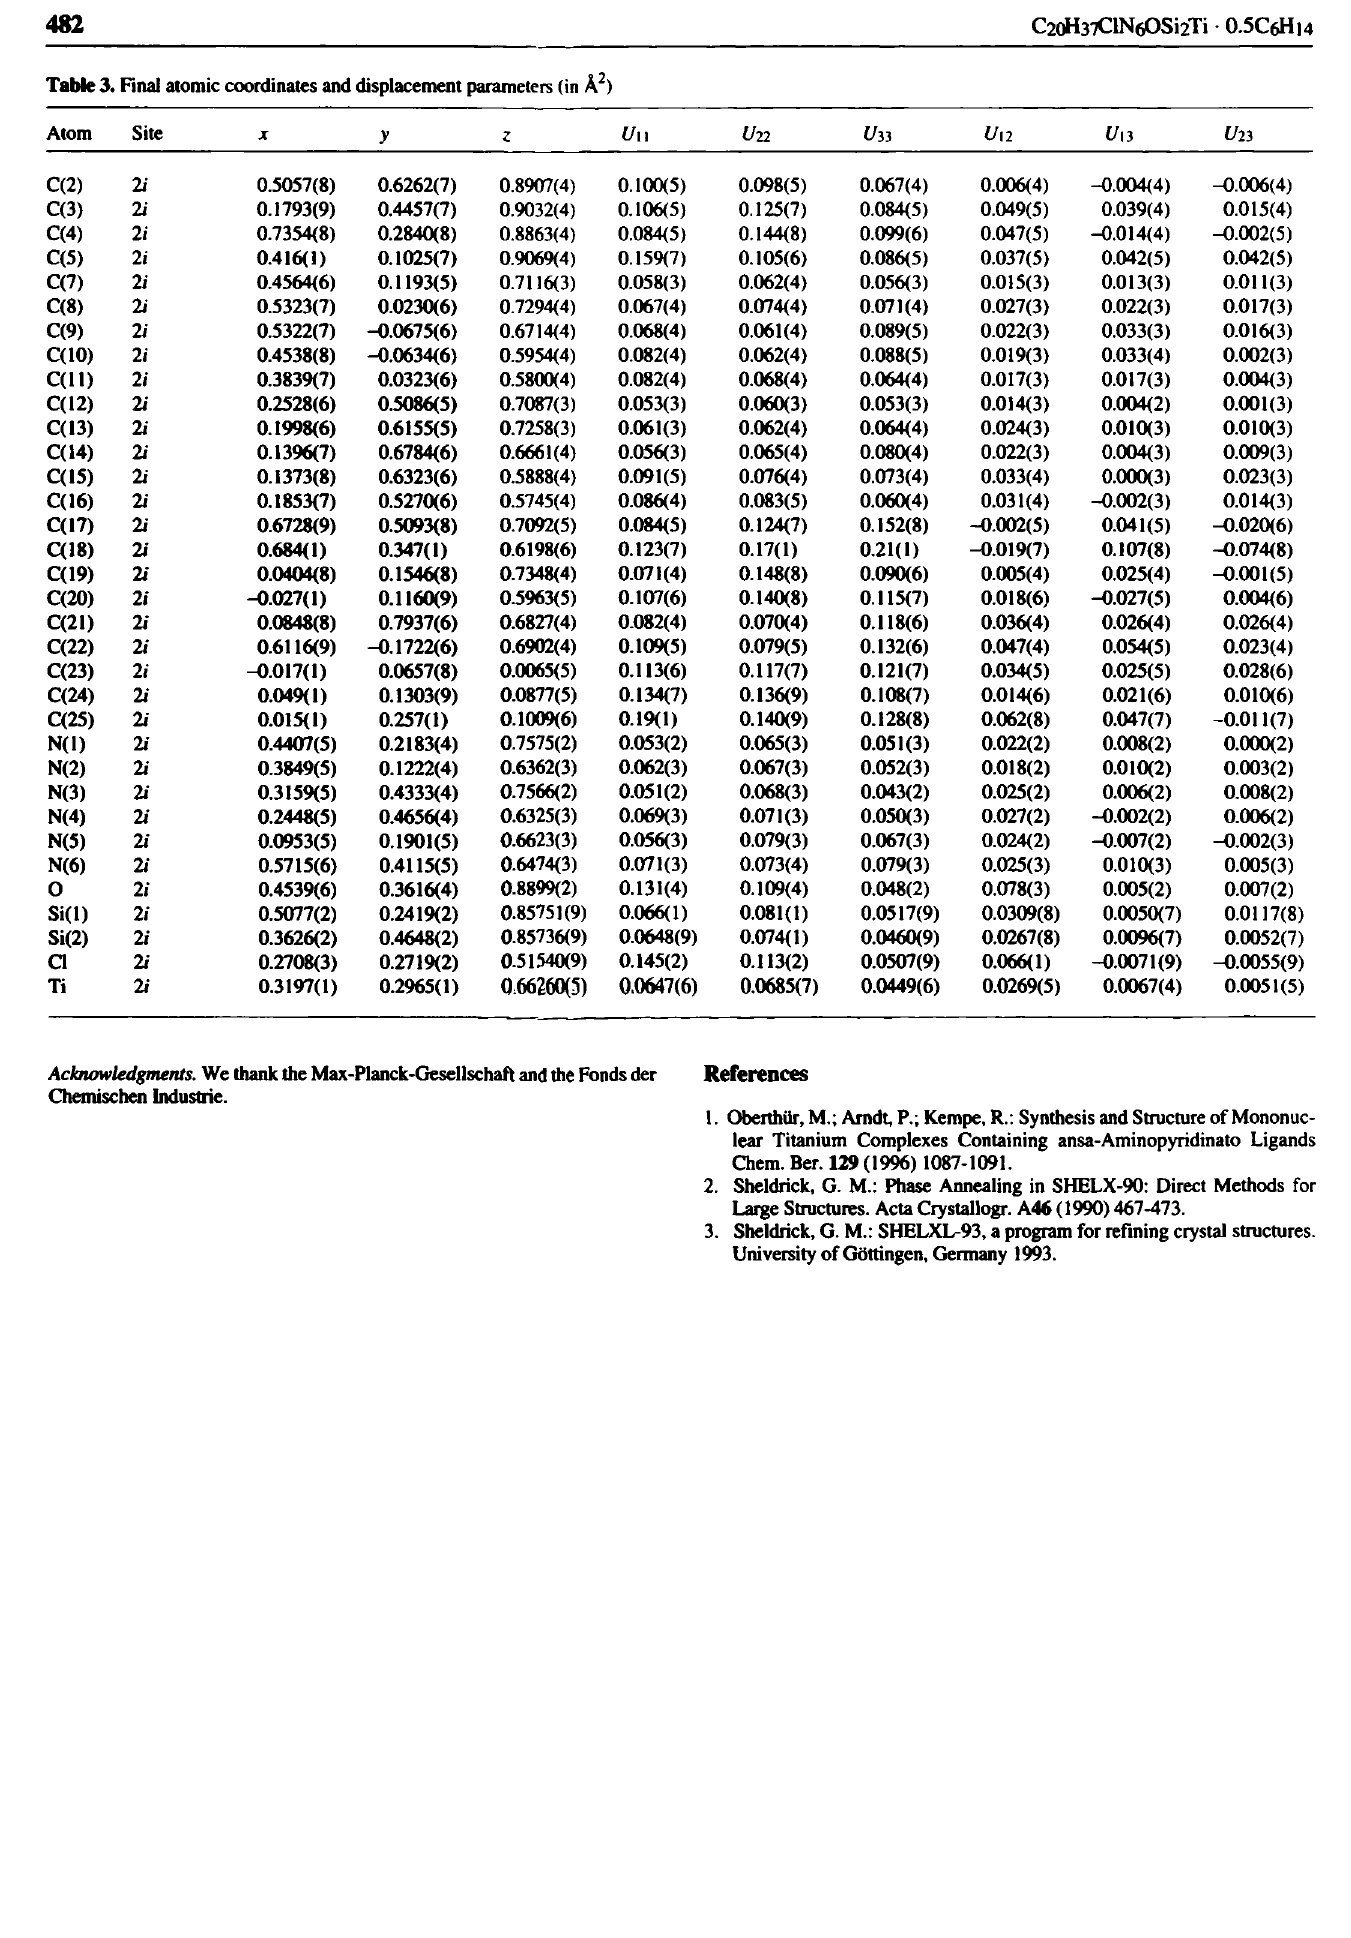
Table 3. Final atomic coordinates and displacement parameters (in Â 2